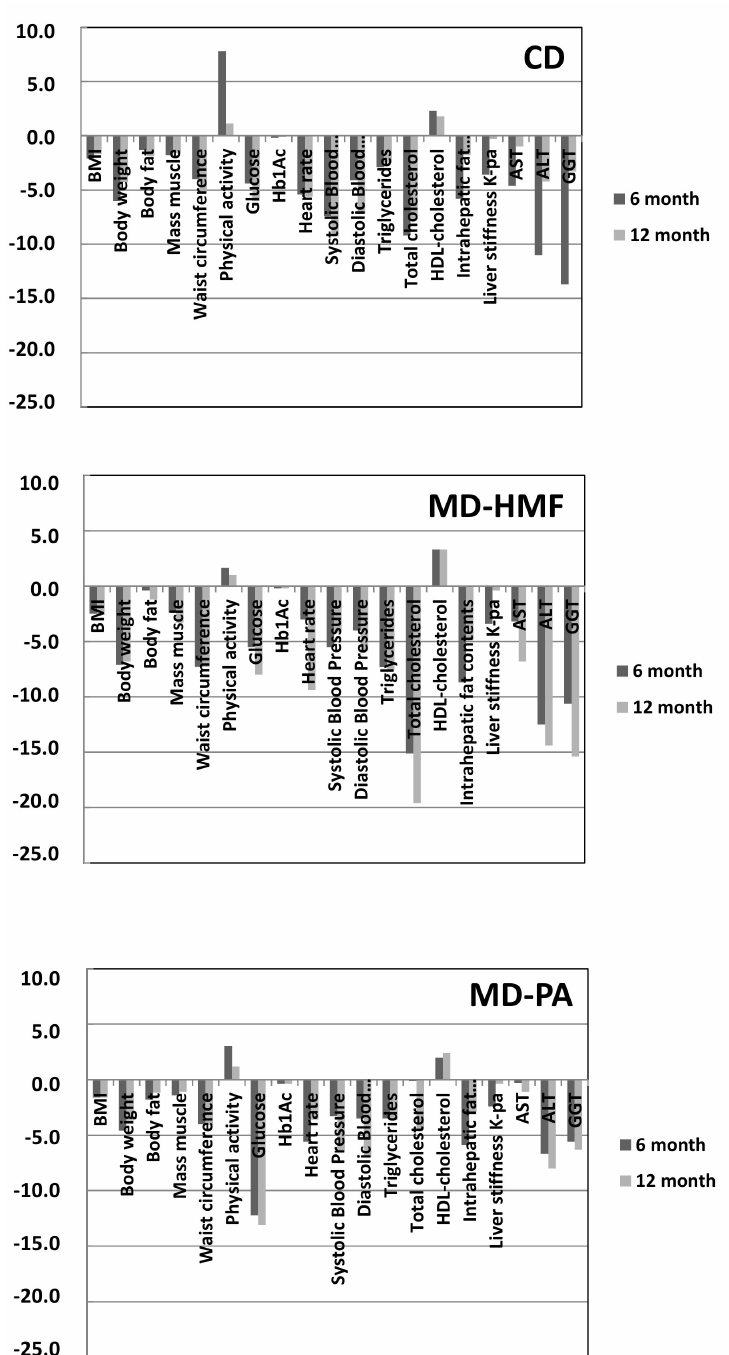
Figure 2. Changes in anthropometric, metabolic, and liver parameters at 6 and 12 months follow- up versus baseline. CD: Conventional Diet; MD–HMF: Mediterranean diet–high meal frequency; MD–PA: Mediterranean diet–physical activity (control group). Physical activity was represented as MET × 10 − 2 . Triglycerides were represented as